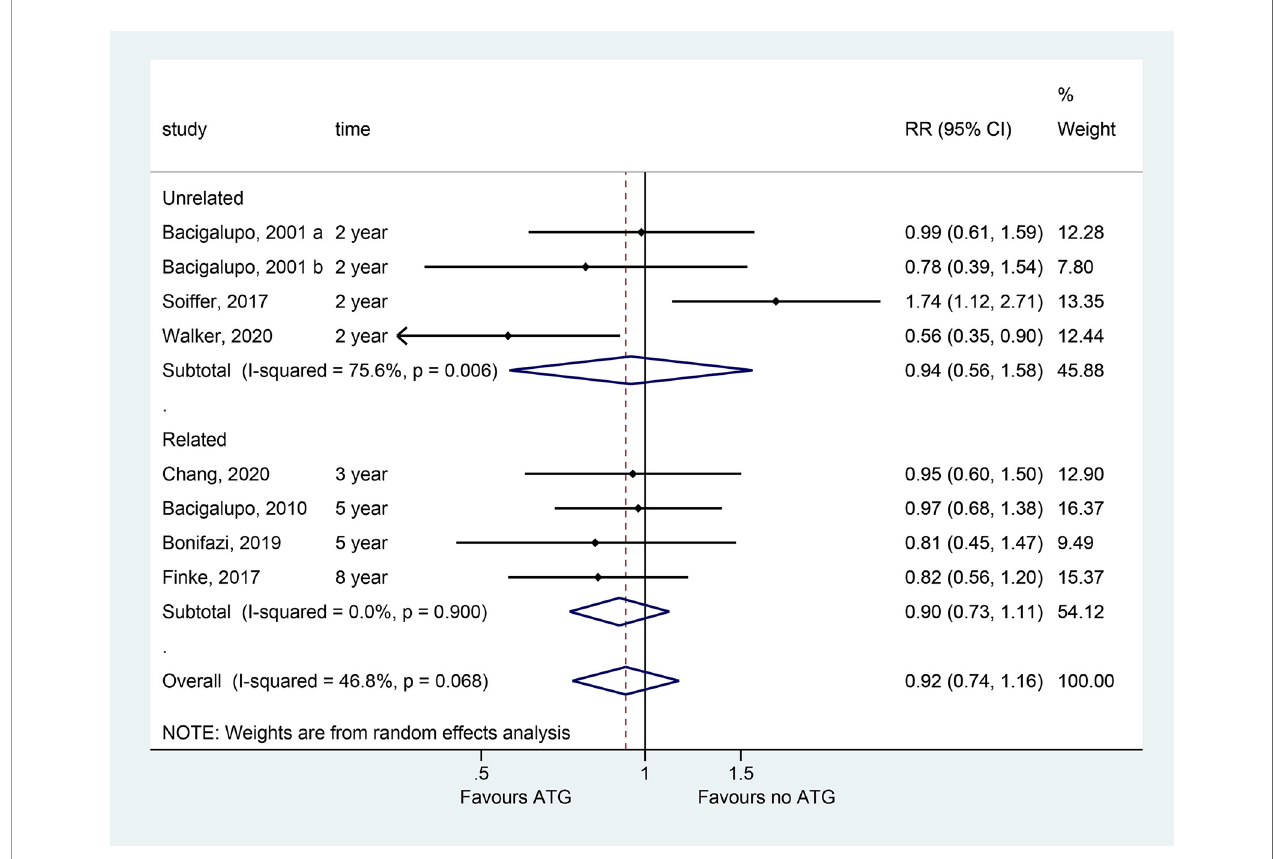
FIGURE 2 | Forest plots of